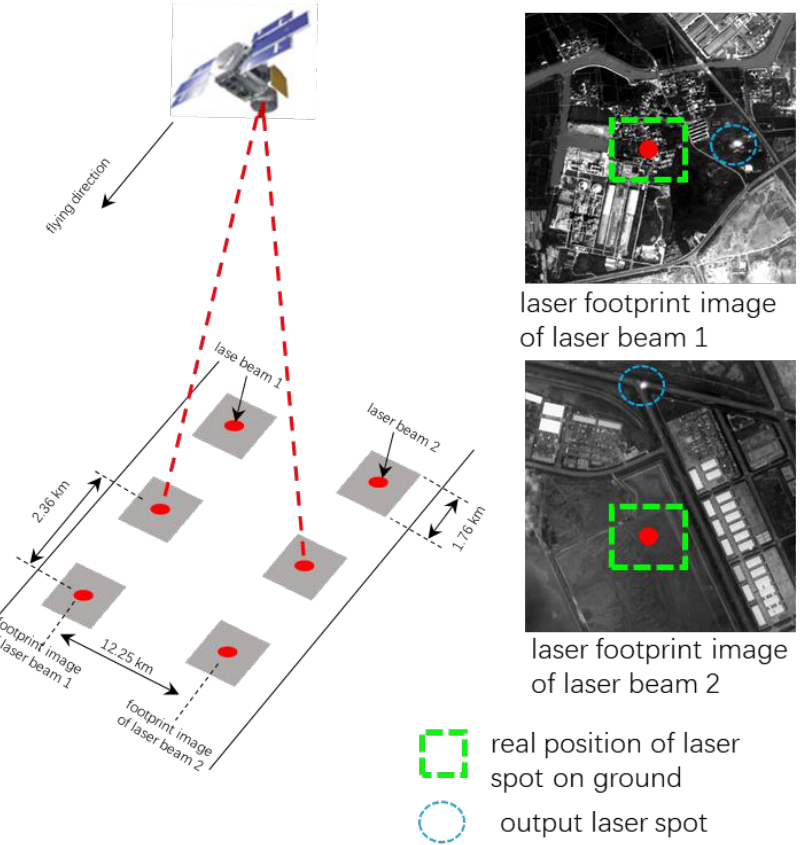
Figure 1. Work schema for laser footprint cameras of GF-7 satellite.